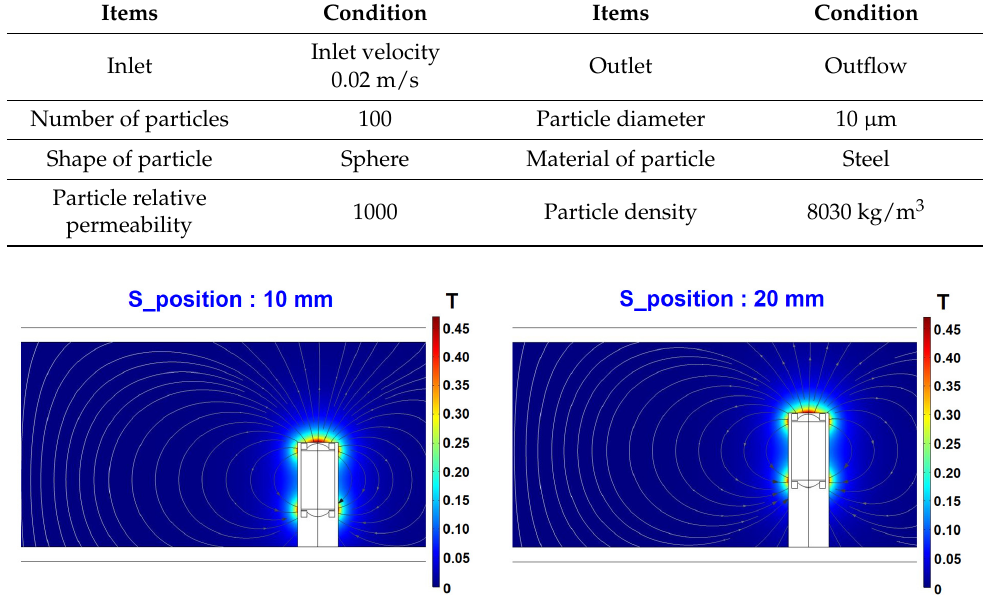
Figure 16. Magnetic flux density in the xz plane with variation of S_position.